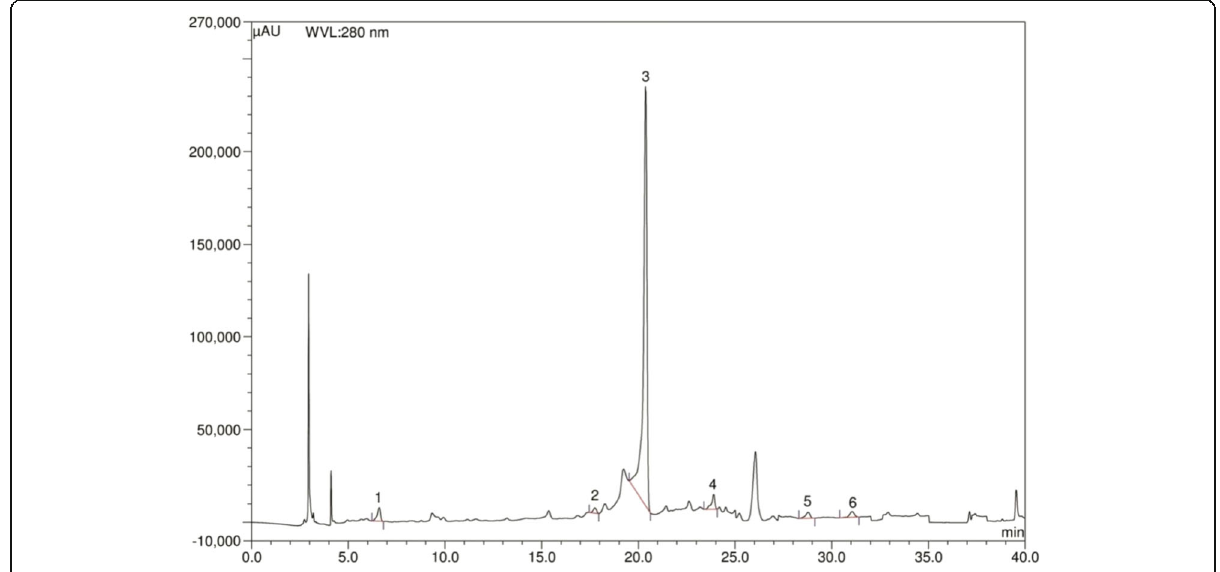
Fig. 3 HPLC chromatogram of stem extract. (Peaks:1: gallic acid; 2: (+)-catechin; 3: vanillic acid; 4: vanillin; 5: ellagic acid; 6: benzoic